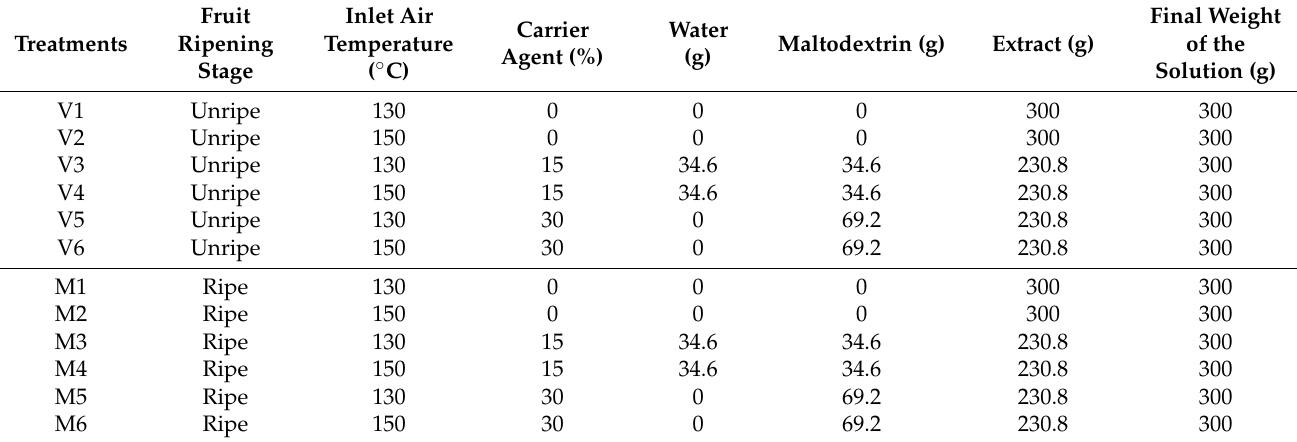
(Table 1) with two replications, making 12 tests in total, for each type of seed. Table 1. Formulations and drying conditions of the